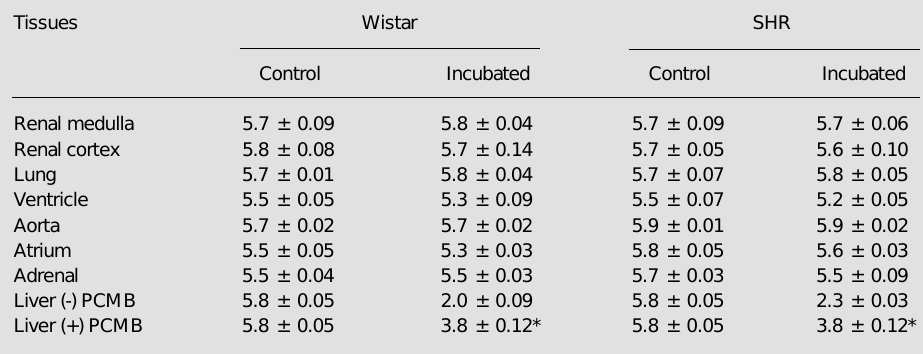
Table 1 - Measurement of dipeptidase activity.